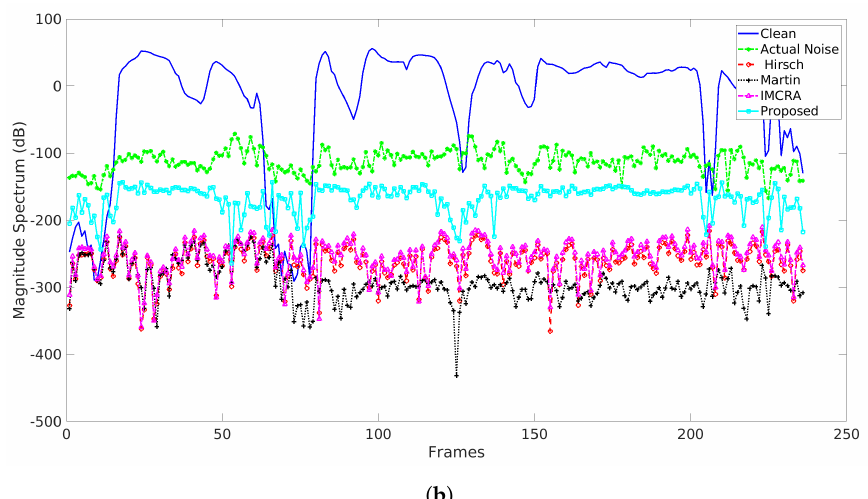
Figure 6. Comparisons of the resulting noise estimation spectra of the proposed method and several noise estimators: Martin, Hirsch, and IMCRA. The figures show the magnitude spectra (in dB) of a frequency bin (k = 10) on ( a ) IMA-ADPCM and ( b ) M-ADPCM. For the proposed method, we used c = 0.8.